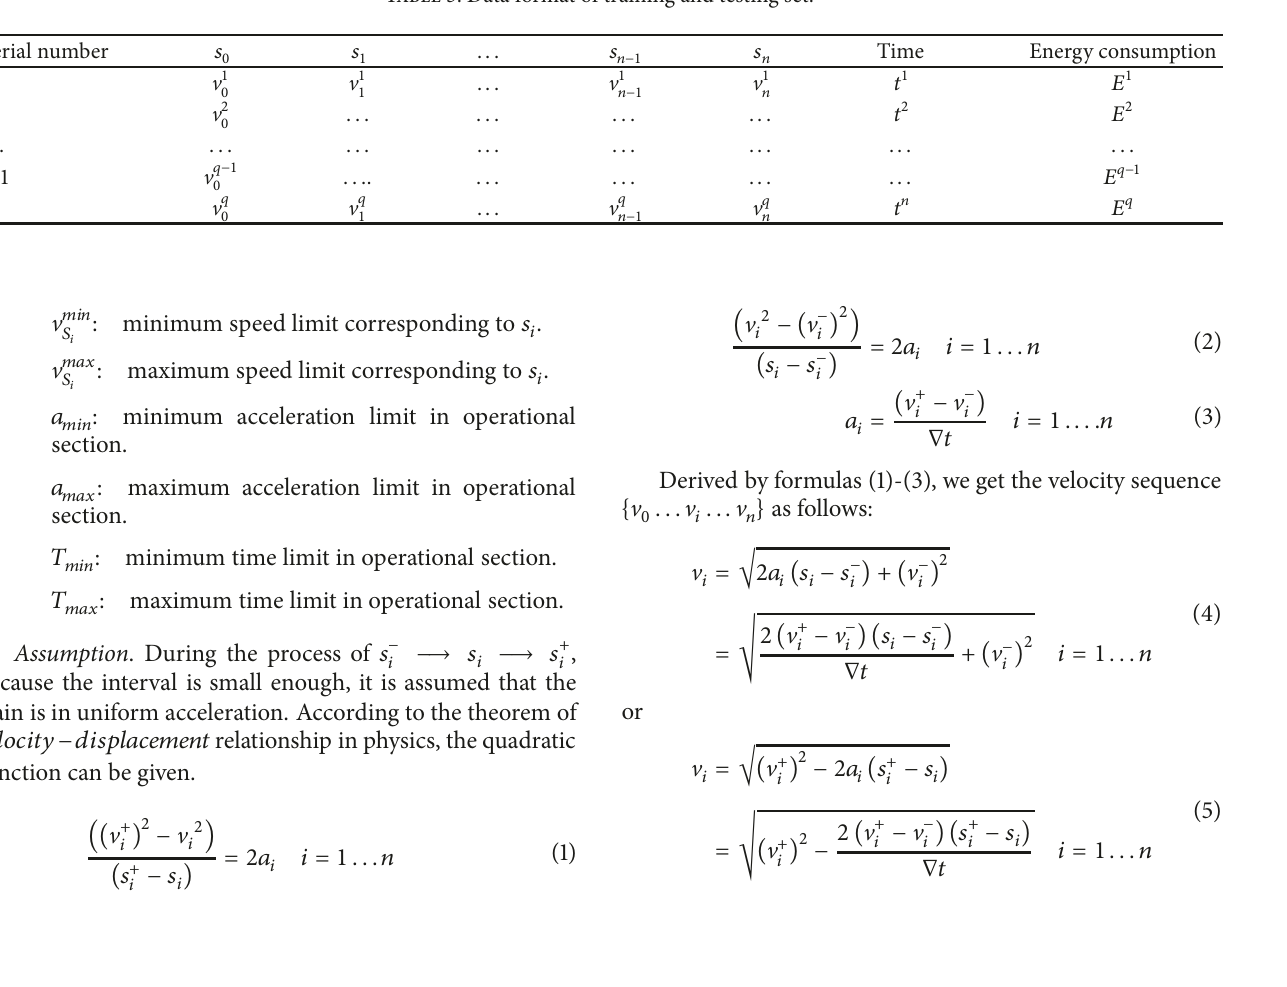
Table 5: Data format of training and testing